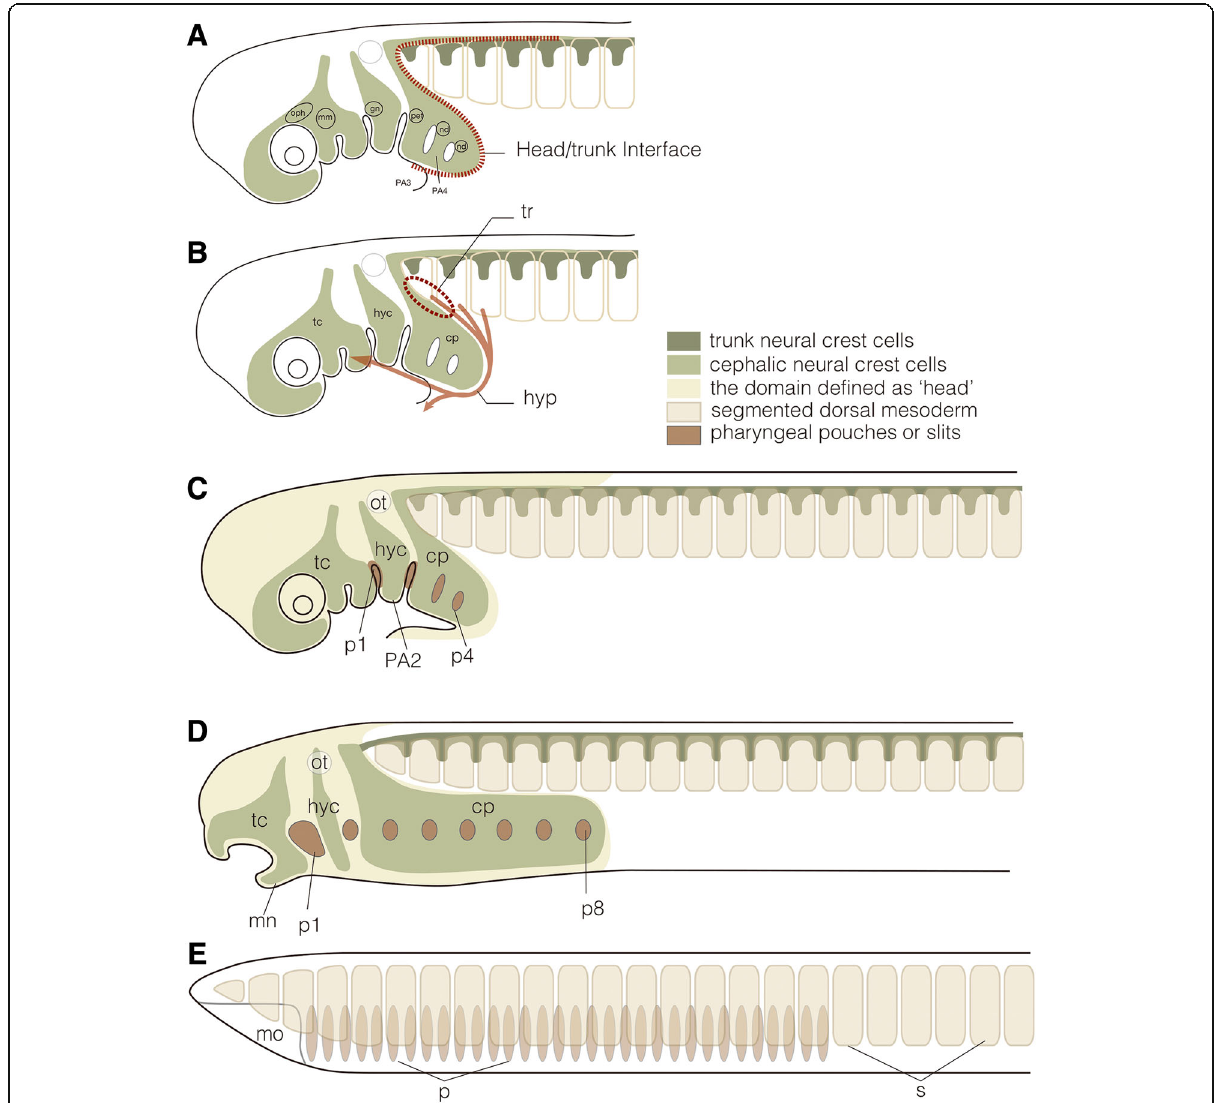
Fig. 6 Head – trunk interface. a to c . Schematic representation of the head and trunk in the pharyngula of modern jawed vertebrates, as defined by the migratory/distribution patterns of neural crest cells (NCCs). In the head of the vertebrate pharyngula, NCCs form extensive ectomesenchyme with three major NCC populations, called trigeminal (tc), hyoid (hyc) and circumpharyngeal crest cells (cp), filling the frontonasal region and pharyngeal arches, defining the vertebrate head (yellowish region in C), as opposed to the posterior domain occupied by somites and the lateral plate. In the trunk, NCCs are segmented primarily into somitomeric streams by the presence of somites (dark green). Between the two distinct groups of NCC populations is found an S-shaped interface (red broken line). Circles denote placodes for cranial nerves (oph, ophthalmic placode; mm, maxillomandibular placode; gn, geniculate placode; pet, petrosal placode; nd, nodose placodes). In B, the position of trapezius muscle development (tr) and pathway of the hypobranchial